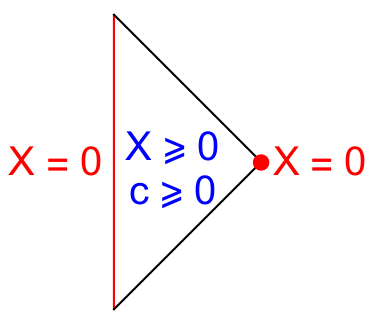
Figure 7 . The right-triangle as a domain for the wave equation together with its boundary condi- tions.